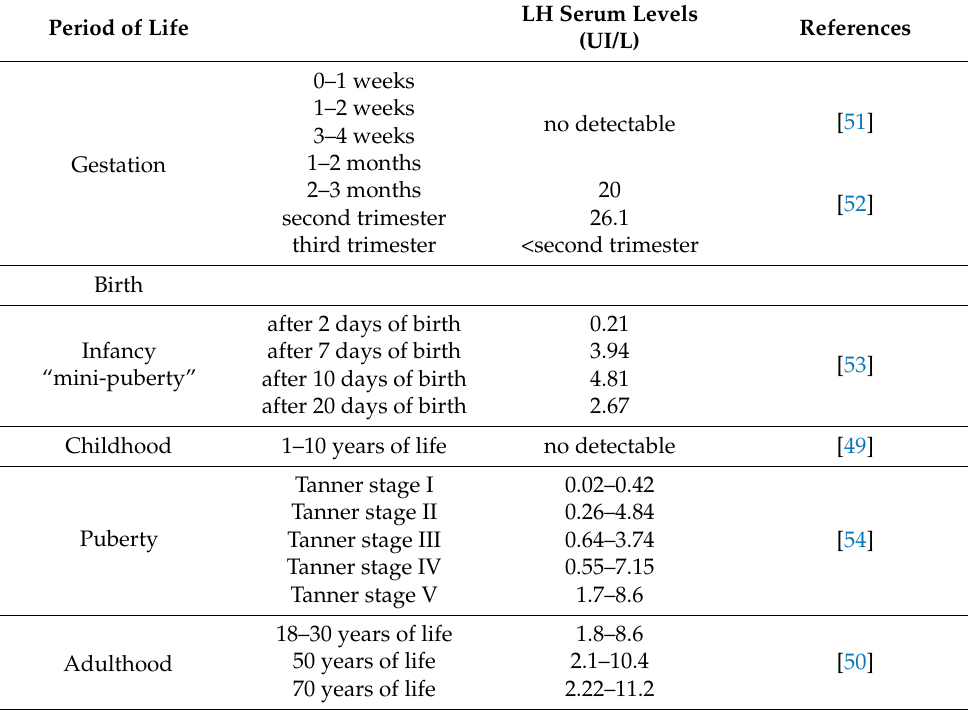
Table 2. Serum LH levels in men, from fetal life to adulthood. Period of Life